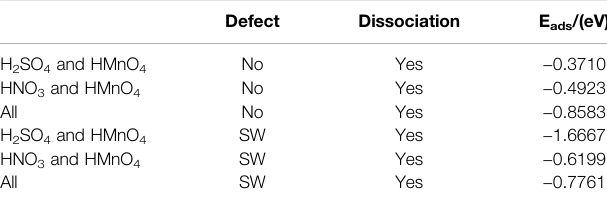
TABLE 4 | Reaction of mixed components on the surface of graphene with